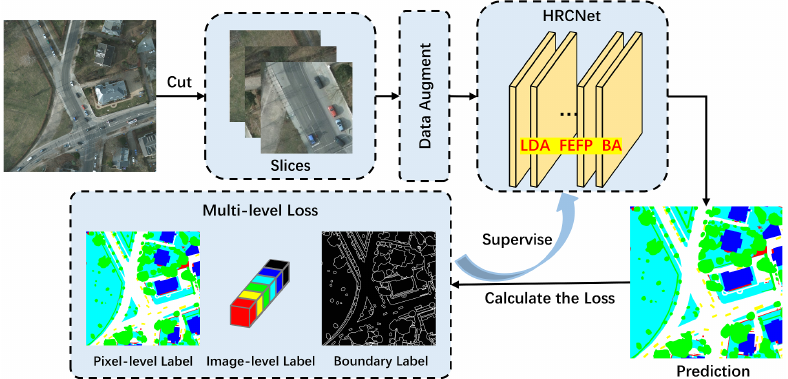
Figure 1. The overall framework of our